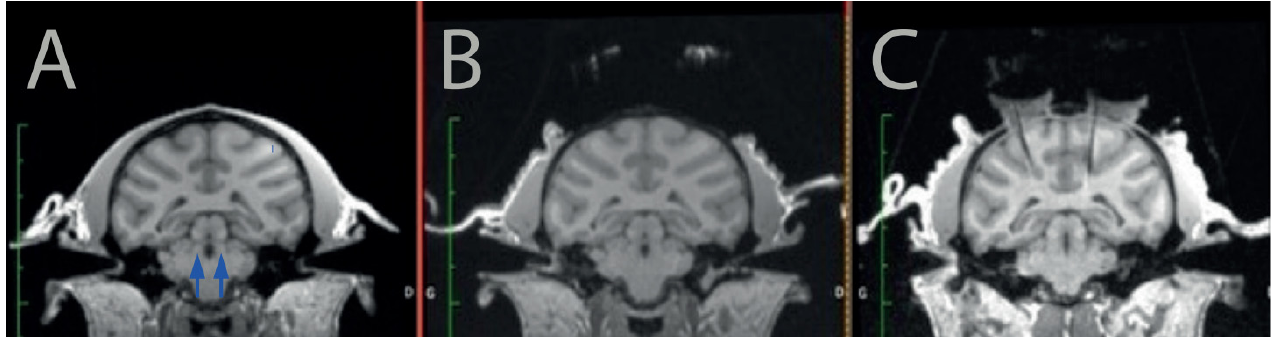
Figure 1. Targeting the LC with MRI. The monkey was first scanned before surgery ( A ) to identify potential trajectories toward the LC (arrows) and to reach it from the surface of the skull without piercing a ventricle or a blood vessel. After the recording cylinders and headpost were implanted surgically, we marked a stereotaxic grid with iodin and scanned the monkey with the grid in place ( B ). After the grid hole that would enable to reach the LC was identified on this second scanner, we scanned the monkey a third time with an electrode inserted in the corresponding grid hole ( C ). The artefact generated by the electrode is clearly visible on the image, and it shows that the trajectory is adequate to target the LC.